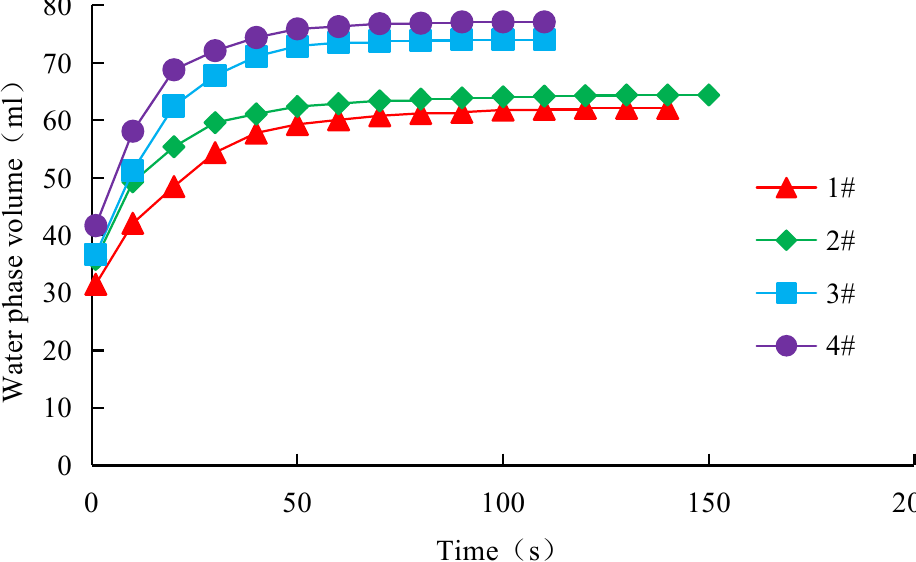
Figure 11. Variation of the volume of water phase in the emulsion system with time under different saturated hydrocarbon contents.